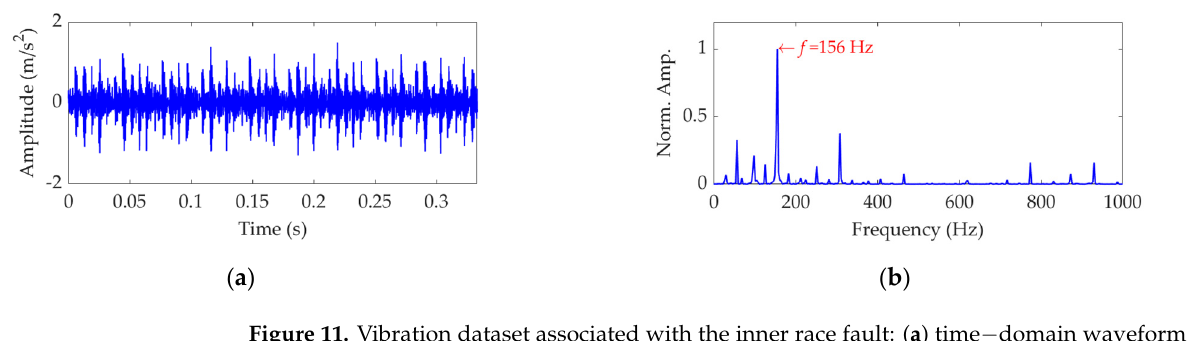
Figure 11. Vibration dataset associated with the inner race fault: ( a ) time − domain waveform and ( b )